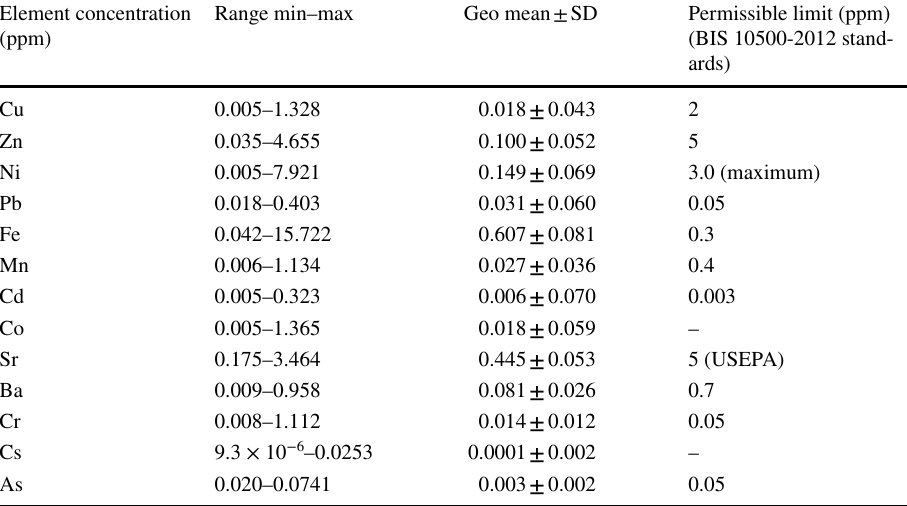
Table 1 Results of trace elements in drinking water samples (Peddagattu and Seripally regions)